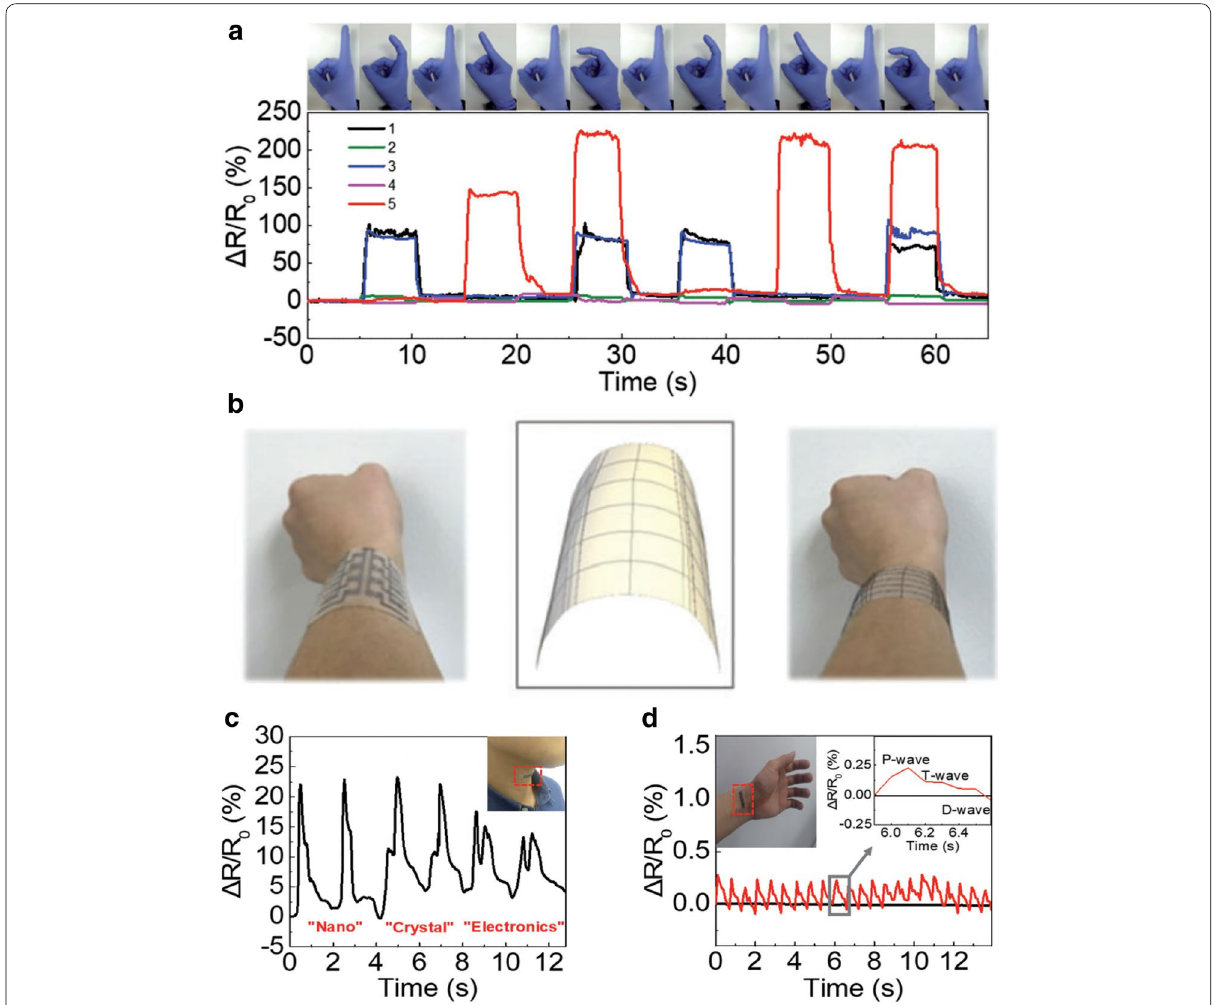
Fig. 4 Applications of NC-based strain sensors for a human motion detection, b human body design, c voice recognition, and d pulse monitoring (Figure reproduced from a , c , and d [59], Copyright 2017, Wiley-VCH; b [50], Copyright 2017, Royal Society of